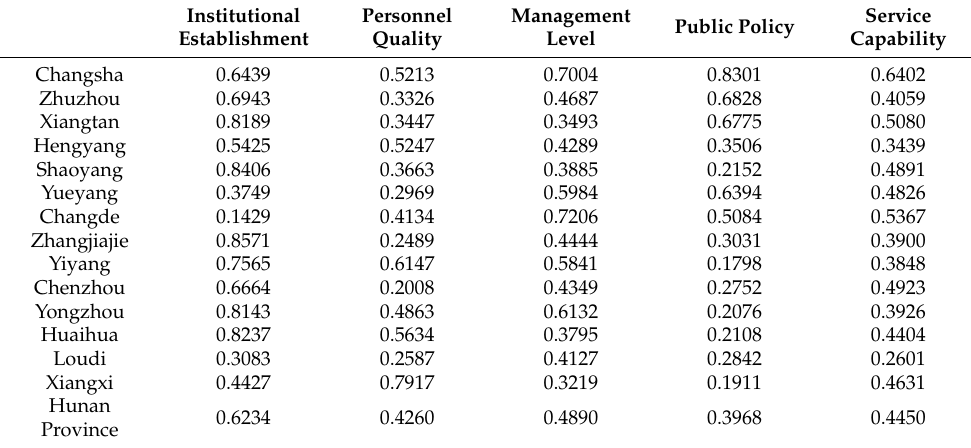
Table 5. Result of closer degree of criterion layer of each city in Hunan Province.